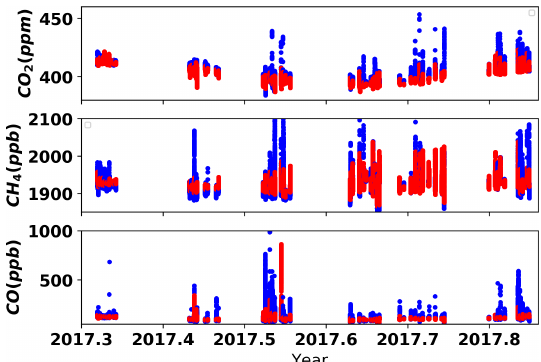
Figure 6. Comparisons of GEOS-simulated atmospheric CO 2 , CH 4 , and CO (red points) versus observed CO 2 , CH 4 , and CO (blue points) during the Arctic-CAP 2017 campaign show good agree- ment across campaigns, although the observed data exhibit larger